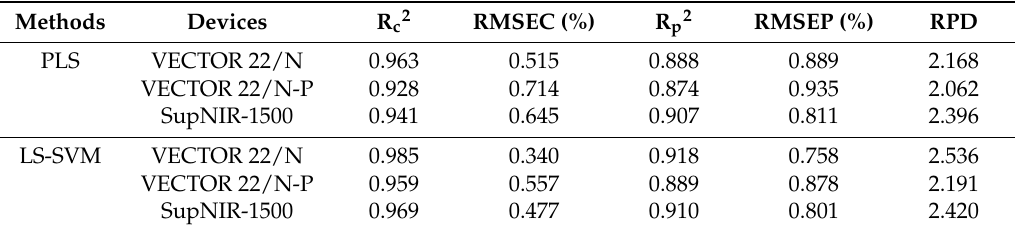
Table 1. Statistics of partial least squares (PLS) and least-squares support vector machine (LS-SVM) regressions for total soluble solid contents of Ruby